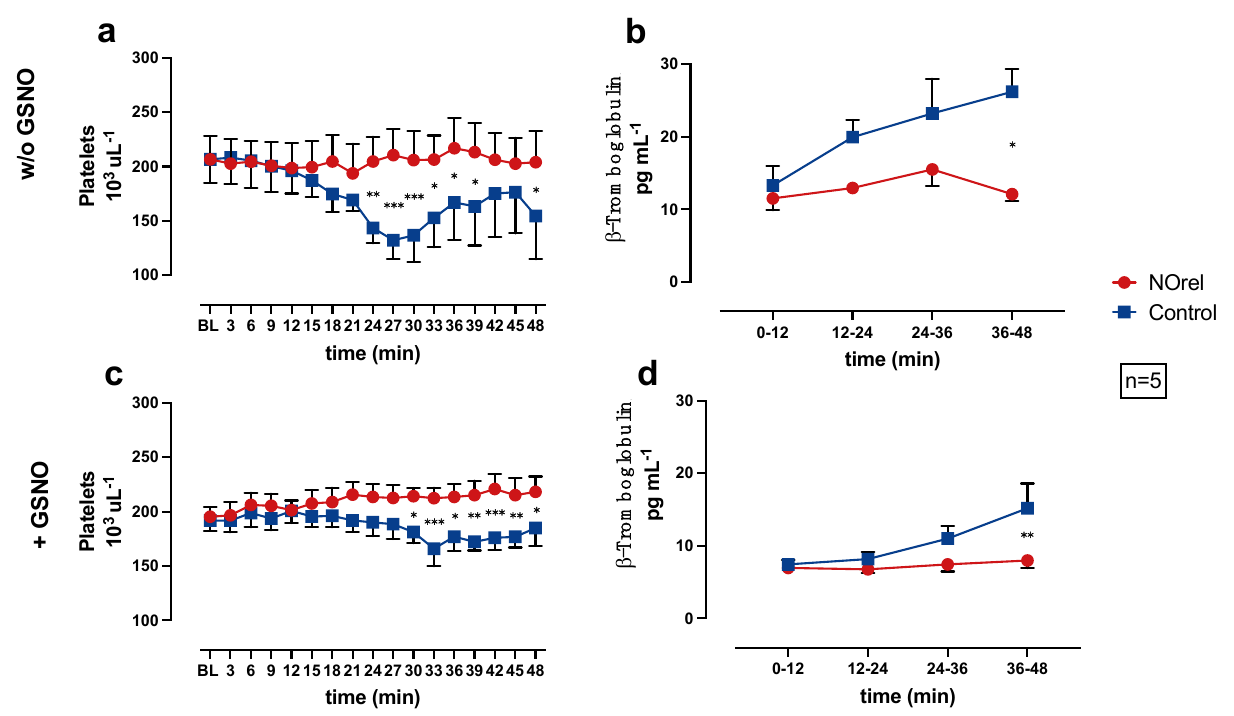
Figure 2. ( a ) Platelets (PLTs) without S-nitrosoglutathione (GSNO)-supplementation, ( b ) β - Thromboglobulin ( β -TG) without GSNO-supplementation, ( c ) PLTs with GSNO-supplementation, ( d ) β -TG with GSNO-supplementation over time. * p < 0.05. ** p < 0.01. *** p <